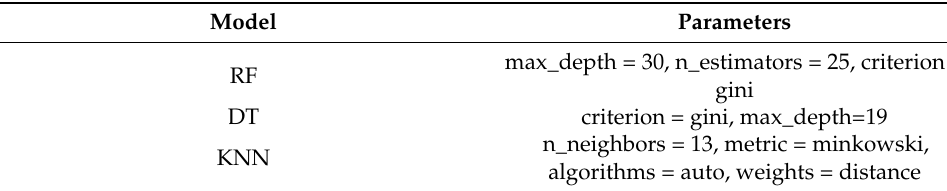
Table 3. Optimal parameters selected for each classification models.